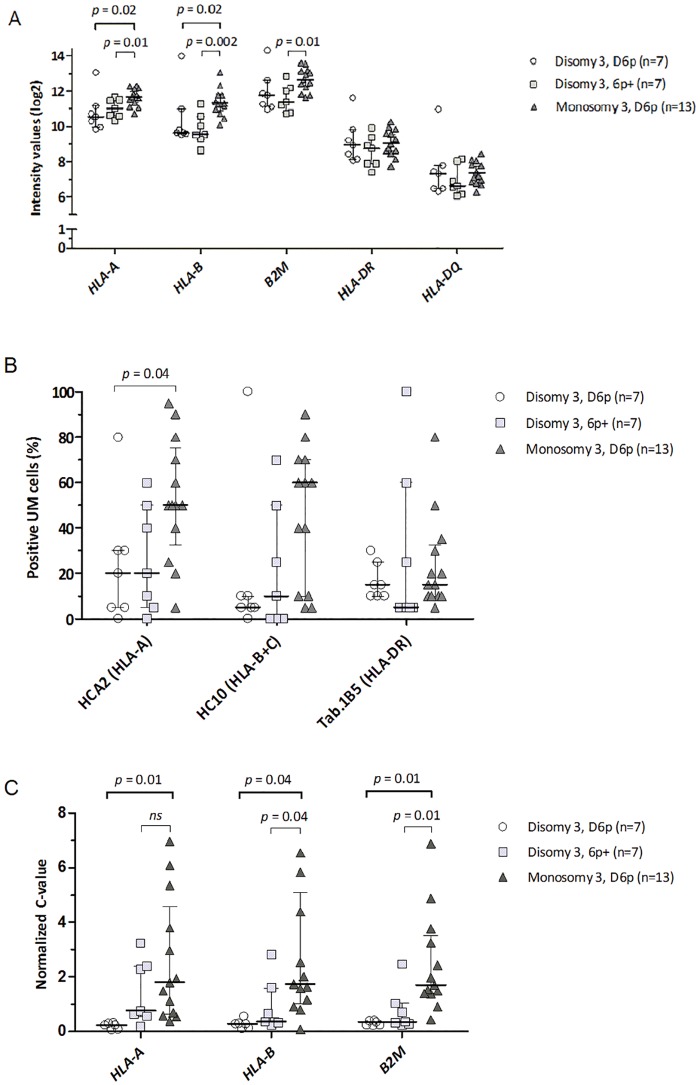
Chromosomal aberrations and HLA expression.Comparison between chromosomal aberrations and the expression of HLA class I and II antigens in a set of 27 primary UM. Tumors are divided according to their chromosome 3 and 6 status (disomy or monosomy of chromosome 3, and disomy of chromosome 6 or gain of 6p). HLA gene expression was determined using an Illumina microarray (A) and protein expression by immunohistochemistry (B) in UM. Additionally, HLA gene expression was determined using qPCR, which served to validate the Illumina findings (C). Four data points of the qPCR that are outside the axis limits (> 11 and < 24) are not shown (HLA-A, D3D6p: 17; HLA-B, D3D6p: 24, and M3D6p: 12; B2M, D3D6p: 13). Only significant p-values are shown, all other comparisons between the groups were not significant (p-values not shown). Error-bars represent the interquartile range. Results were obtained using the Mann-Whitney U tests.